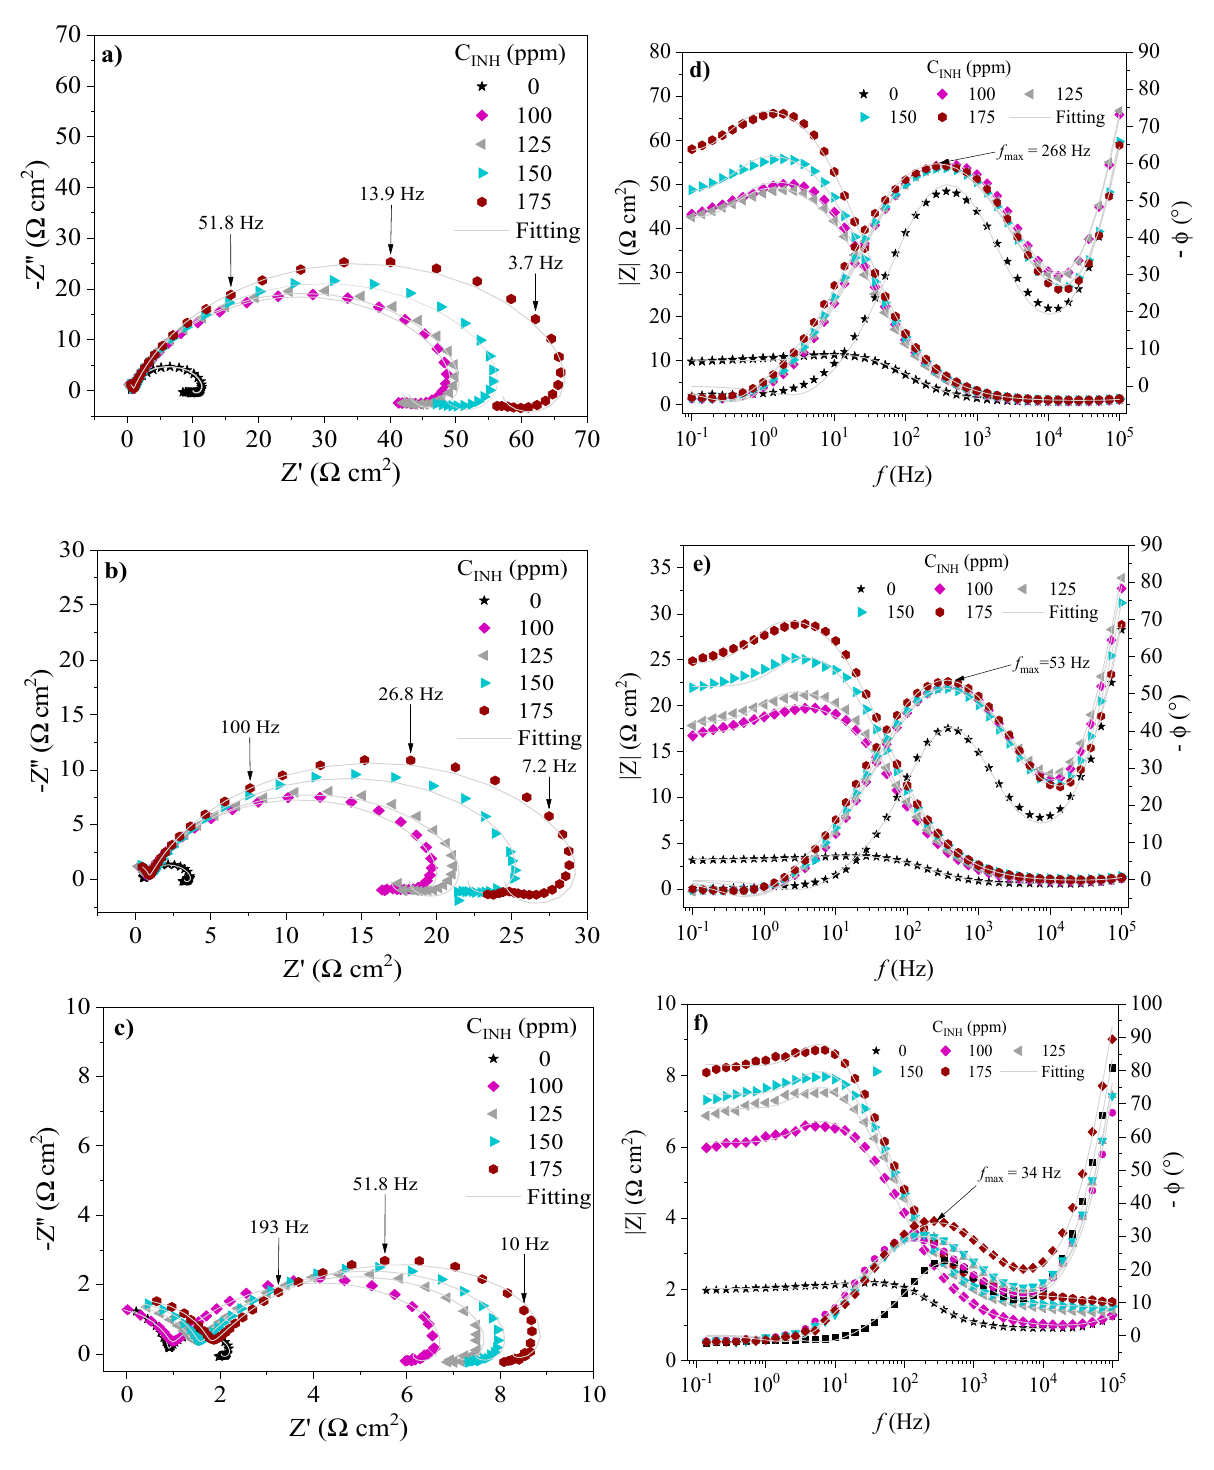
Figure 7. EIS spectra of API 5L X60 steel in 1 M H 2 SO 4 in the presence of Poly[VIMC4][Im]: Nyquist [( a ) 308 K, ( b ) 318 K and ( c ) 328 K] and Bode [( d ) 308 K, ( e ) 318 K and ( f ) 328 K].